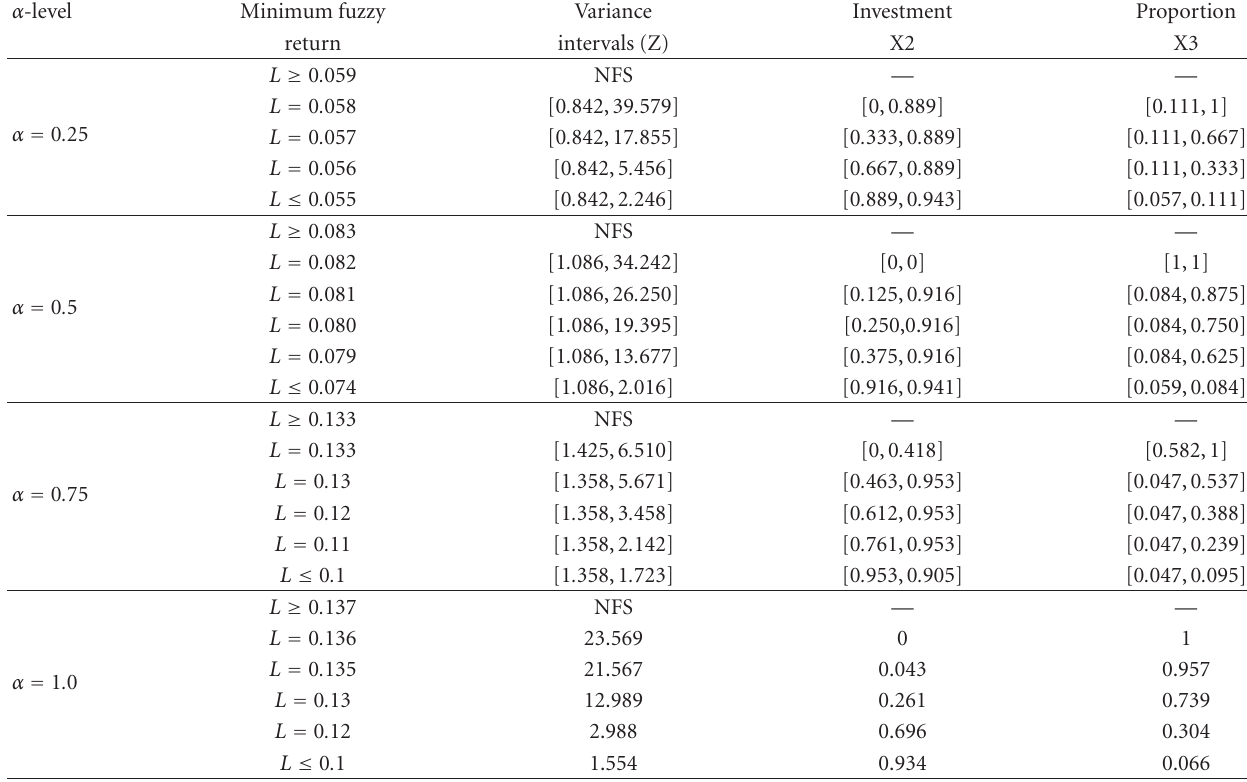
Table 4: Investment proportions with di ff erent levels of α for minimizing